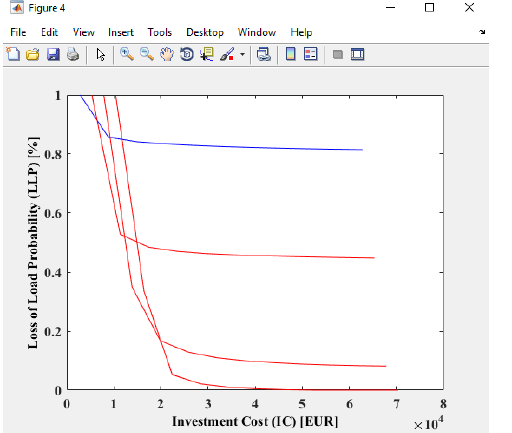
Figure 14. Irradiation and Load at average 6 hours